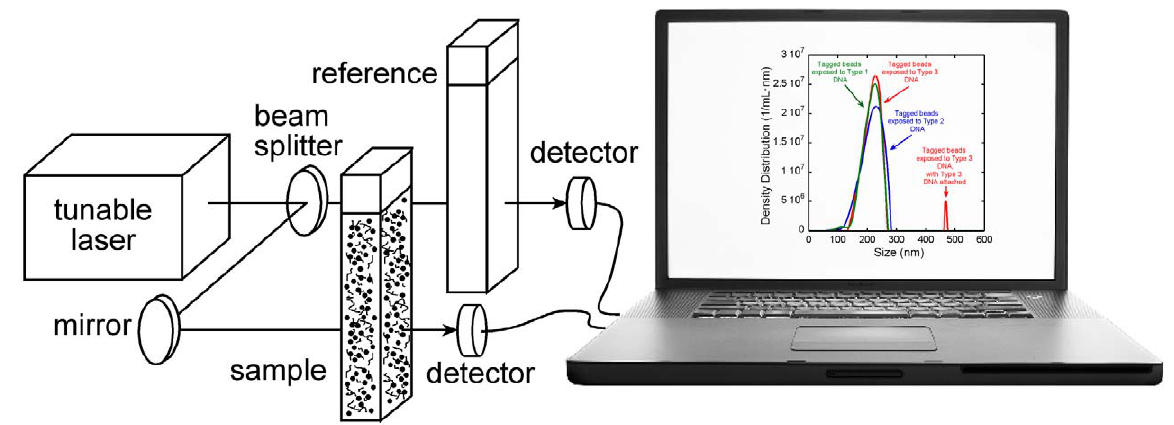
Figure 1. Schematic diagram of DNA detection using LTS.